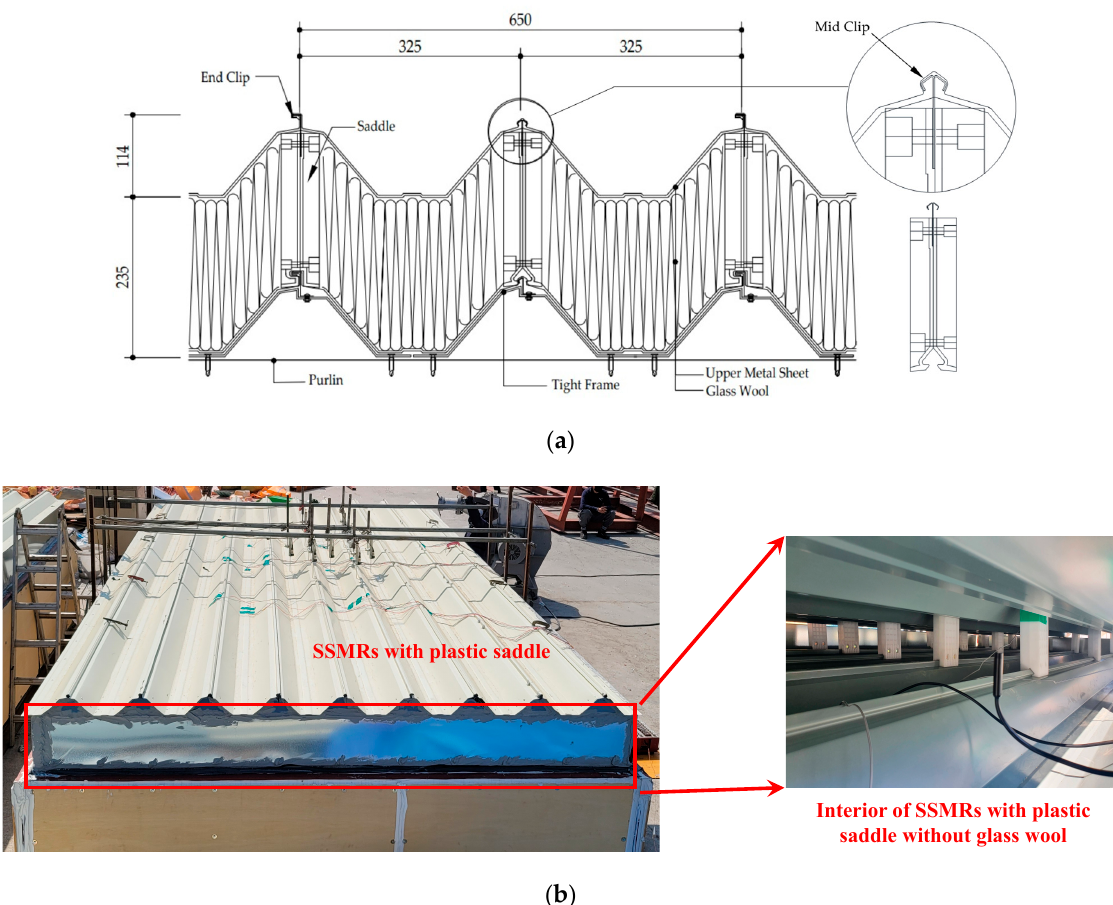
Figure 1. Tested SSMRs with a plastic saddle: ( a ) schematic design (unit: mm), ( b ) exterior–interior view.